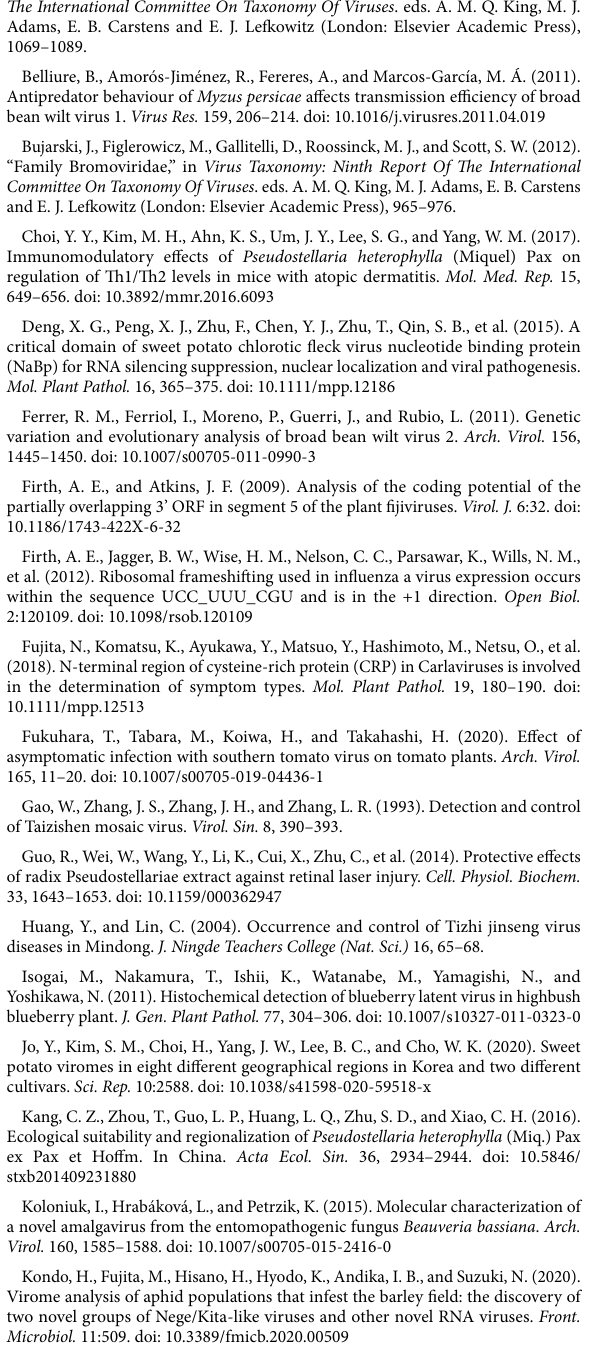
SUPPLEMENTARY TABLE S7 Pairwise nucleotide identities of the CP of PhCV1, PhCV2, PhCV3, Ph- JVC, Ph-StCV1, and the 15 most similar carlaviruses.